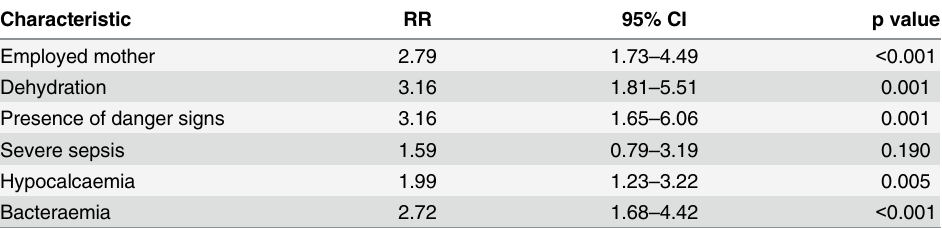
Table 6. Results of log-linear binomial regression, to identify independent risk factors for deaths in SAM children presenting with cough or respiratory difficulty and radiological pneumonia and who received standard WHO